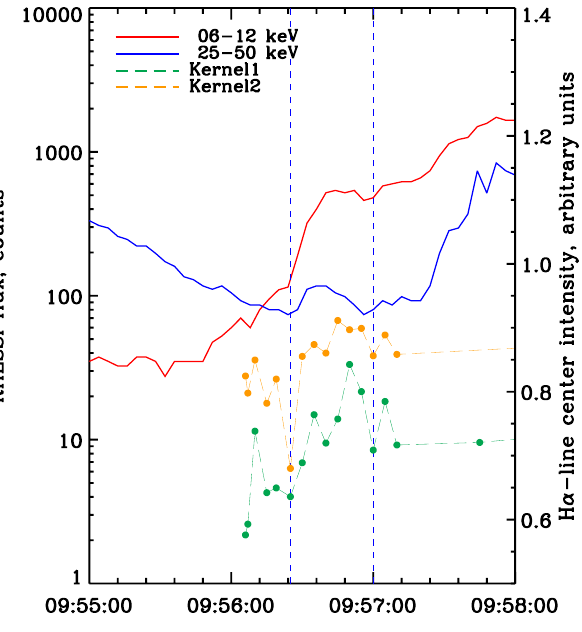
Fig. 6. Top: H α /H β ratio profiles at 09:56:45UT for kernel 1 (green) and kernel 2 (orange). Bottom: MFS image composed of H α spectrum, H α slit-jaw and H β spectrum. The locations of ker- nels are marked by corresponding colors.